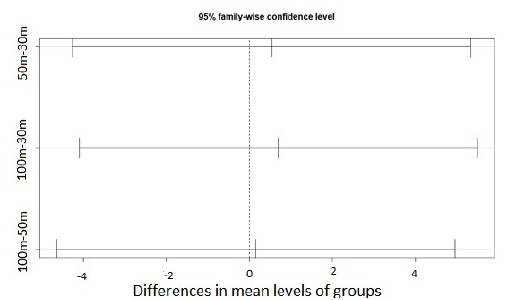
Figure 3. Post-hoc Tukey HSD test results of Water Temperature (°C) between riparian zone width categories.